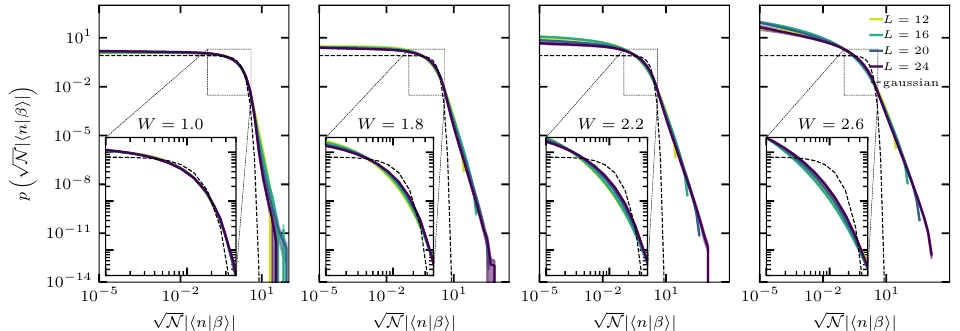
Figure 1: Normalized probability density of scaled eigenstate coefficients in the com- (cid:112) (cid:0) (cid:1) N |〈 n | β 〉| putational basis, P for disorder strengths W = 1.0,1.8,2.2 and 2.6 and system sizes L = 12,16,20 and 24 (larger systems correspond to darker colors). The dashed black line represents the normal distribution and errorbars are represented by shaded areas of the order of the line